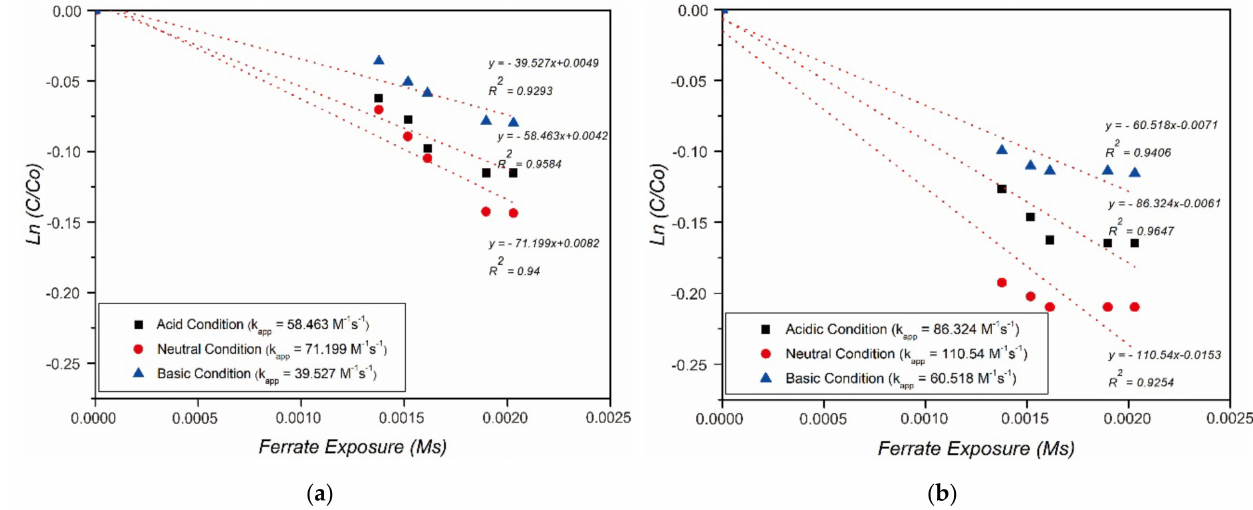
Figure 4. Rate of ( a ) bromobenzene and ( b ) chlorobenzene removal by ferrate(VI) at various pH